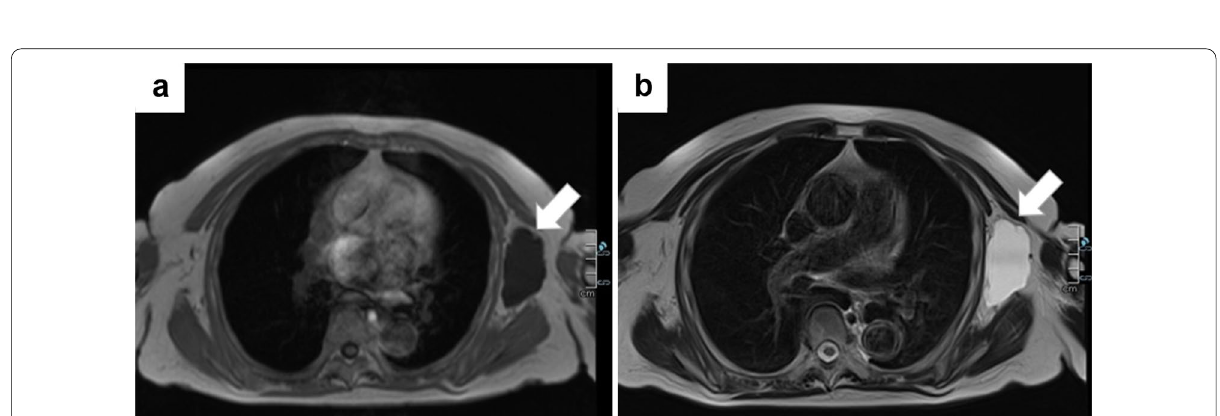
Fig. 2 Magnetic resonance imaging (MRI) findings. Compared with the surrounding muscle, the left axillary mass showed a low signal on T1-weighted imaging ( a ) and high signal on T2-weighted imaging ( b